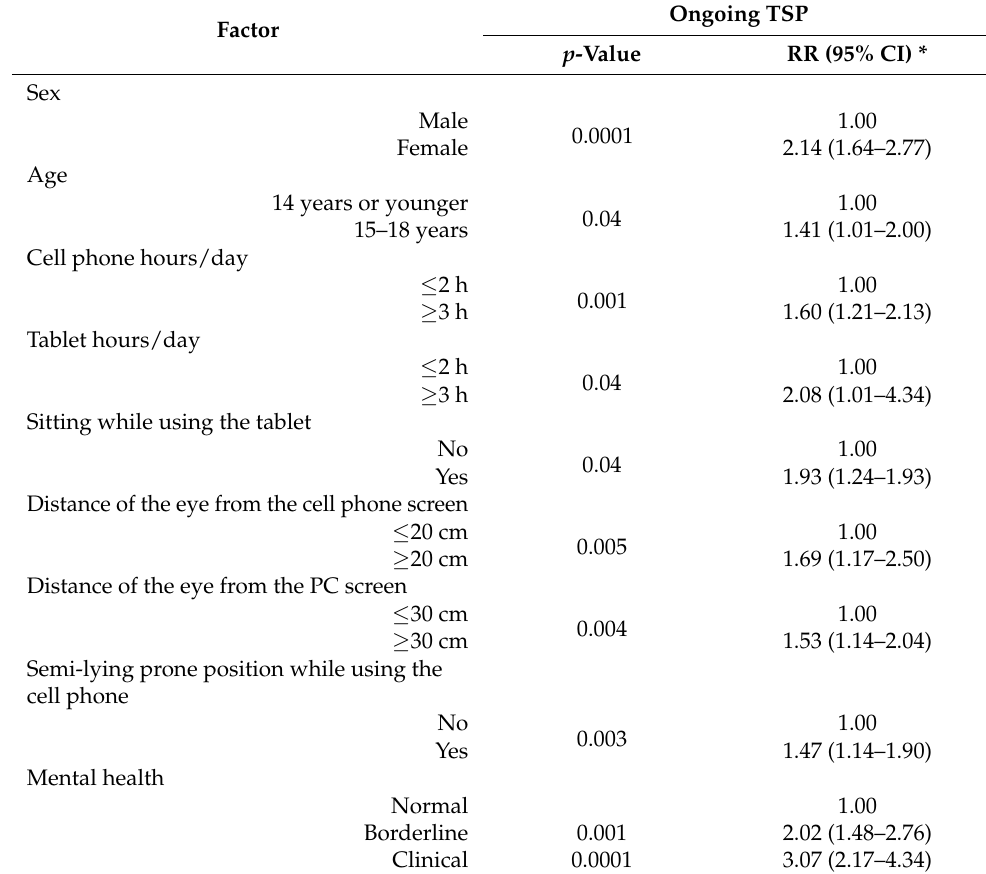
Table 3. Multivariate logistic regression comparing no TSP during either T1 or T2 (score = 0) with TSP during both T1 and T2 (score =